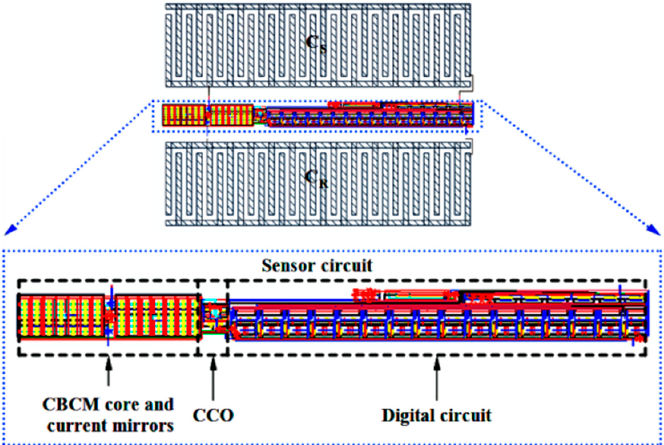
Figure 22. Layout of the proposed capacitive sensor, along with sensing and reference electrodes.